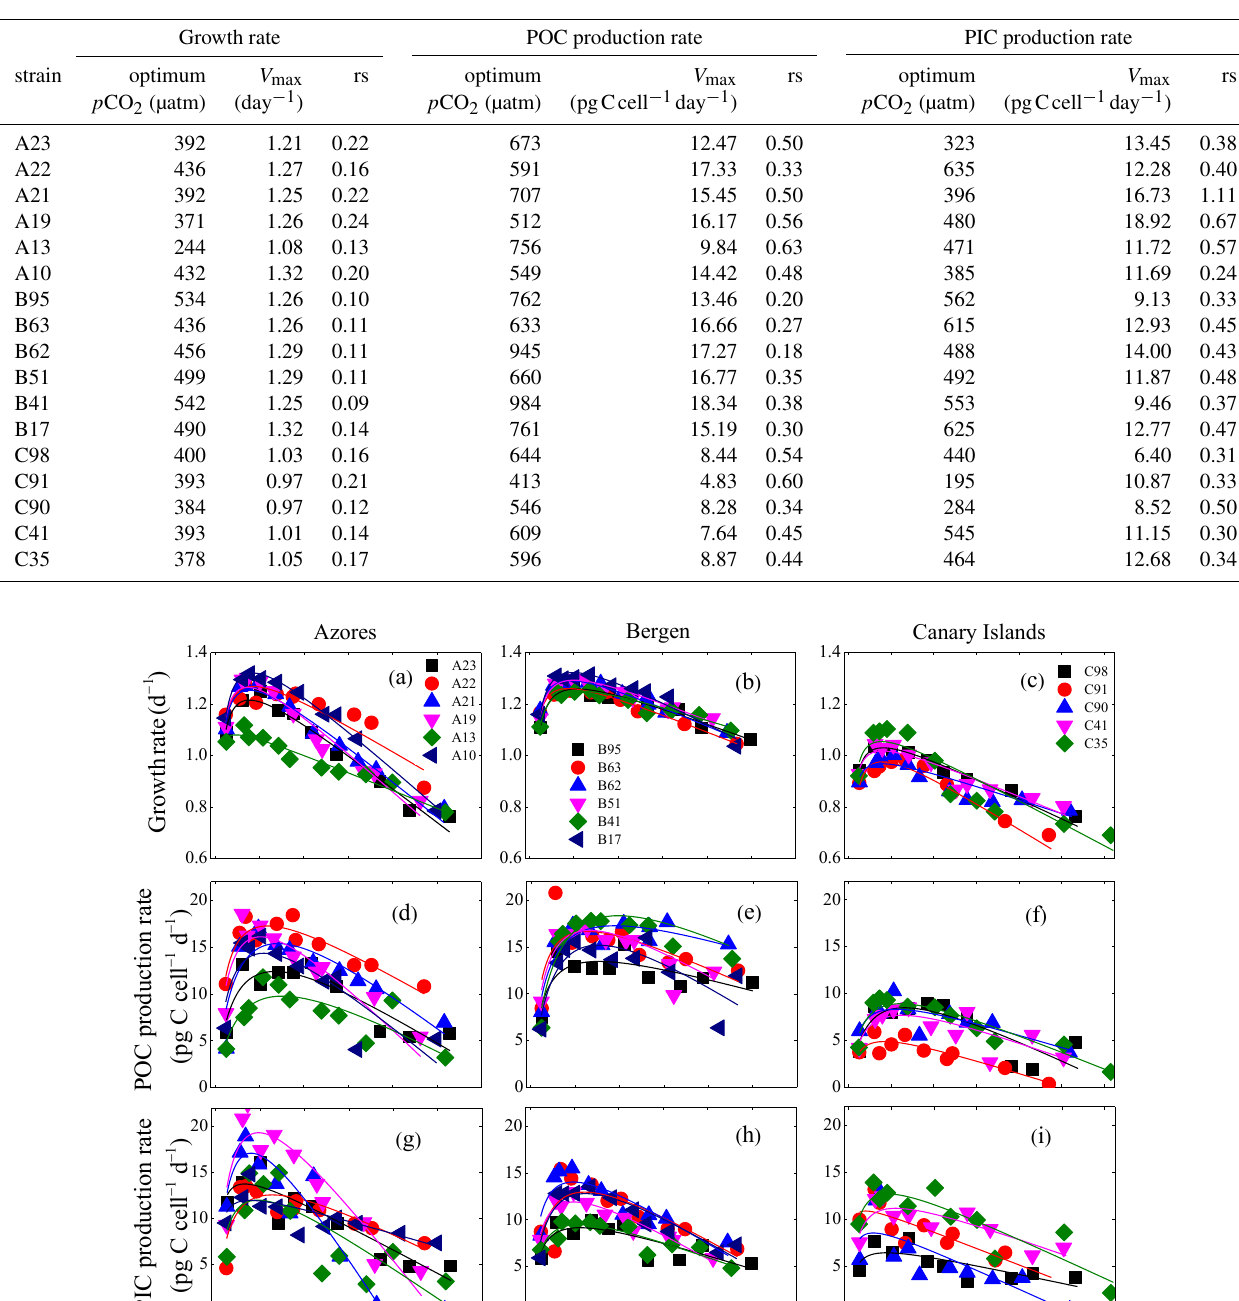
Table 3. Calculated optimum p CO 2 , calculated maximum value ( V max ) , and fitted relative sensitivity constant (rs, ‰) of growth, POC, and PIC production rates of each E. huxleyi strain.